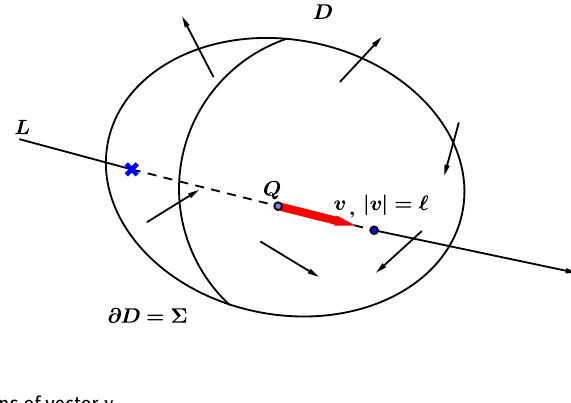
Figure 1: Random intersections of vector